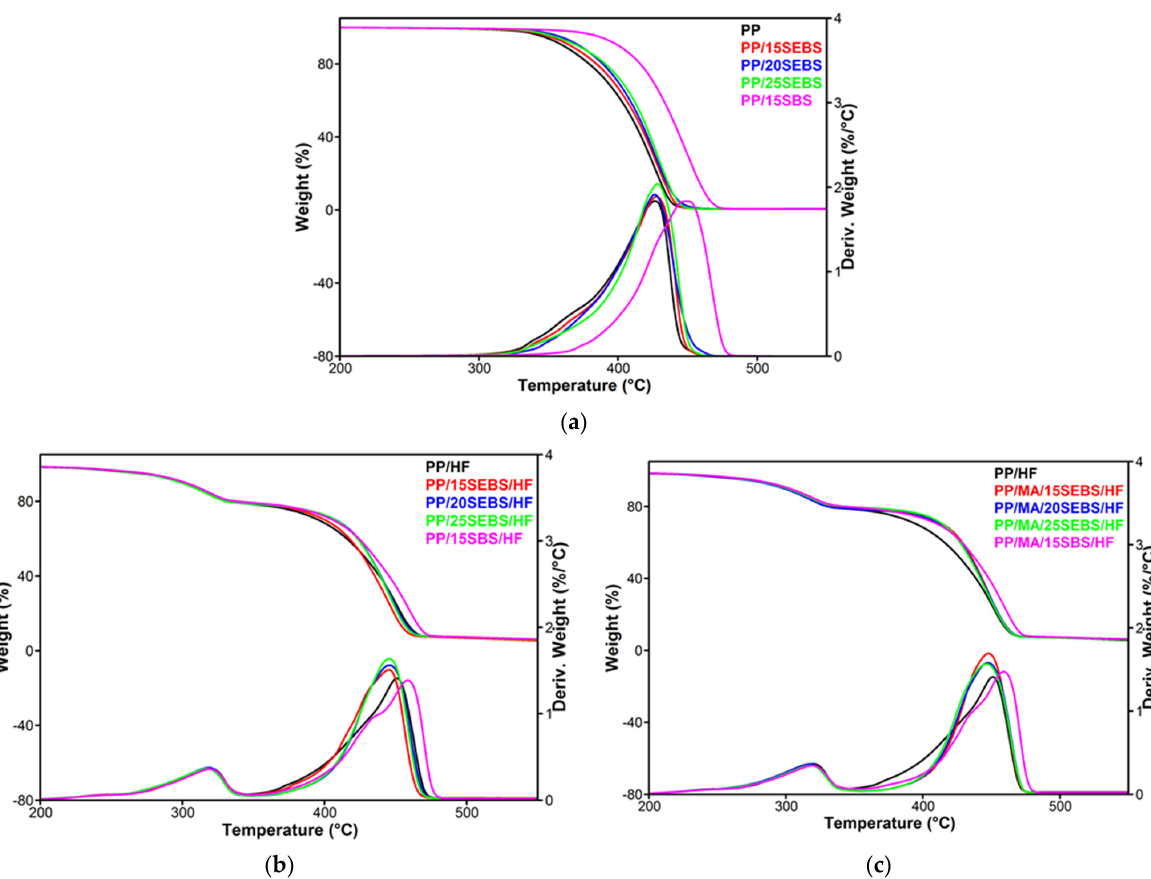
Figure 9. Thermogravimetric (TG) and derivative (DTG) curves for PP blends ( a ) and composites without MAPP compatibilizer ( b ) and with MAPP compatibilizer ( c ). Table 4. TG–DTG results.